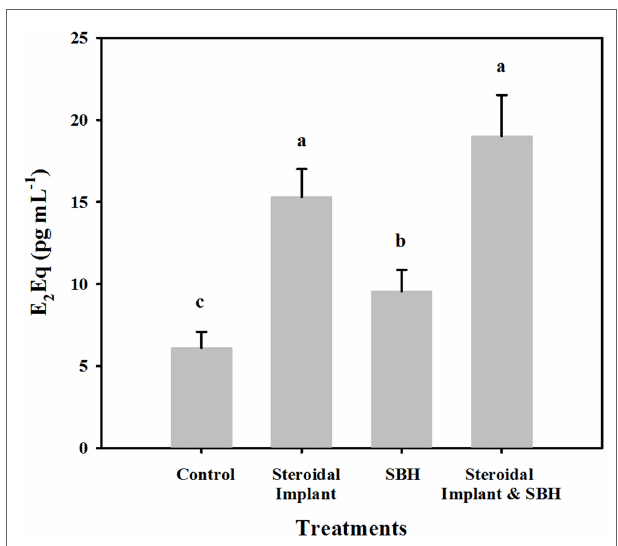
FigUre 2 | Mean serum prolactin levels in steers grazing toxic endophyte-infected [ Epichloë coenophiala (Morgan-Jones & W. gams) c. W. Bacon & schardl] tall fescue [ Lolium arundinaceum (schreb.) Darbysh] and treated ( n = 4 steers per treatment groups) with or without an estradiol–progesterone ear implant and soybean hull (sBh) feeding combinations . Values are averages over 2 years, two sample dates per year (6/14 and 7/5/2007; 6/24 and 7/24/2008). Means with different letters are different ( P ≤ 0.05).